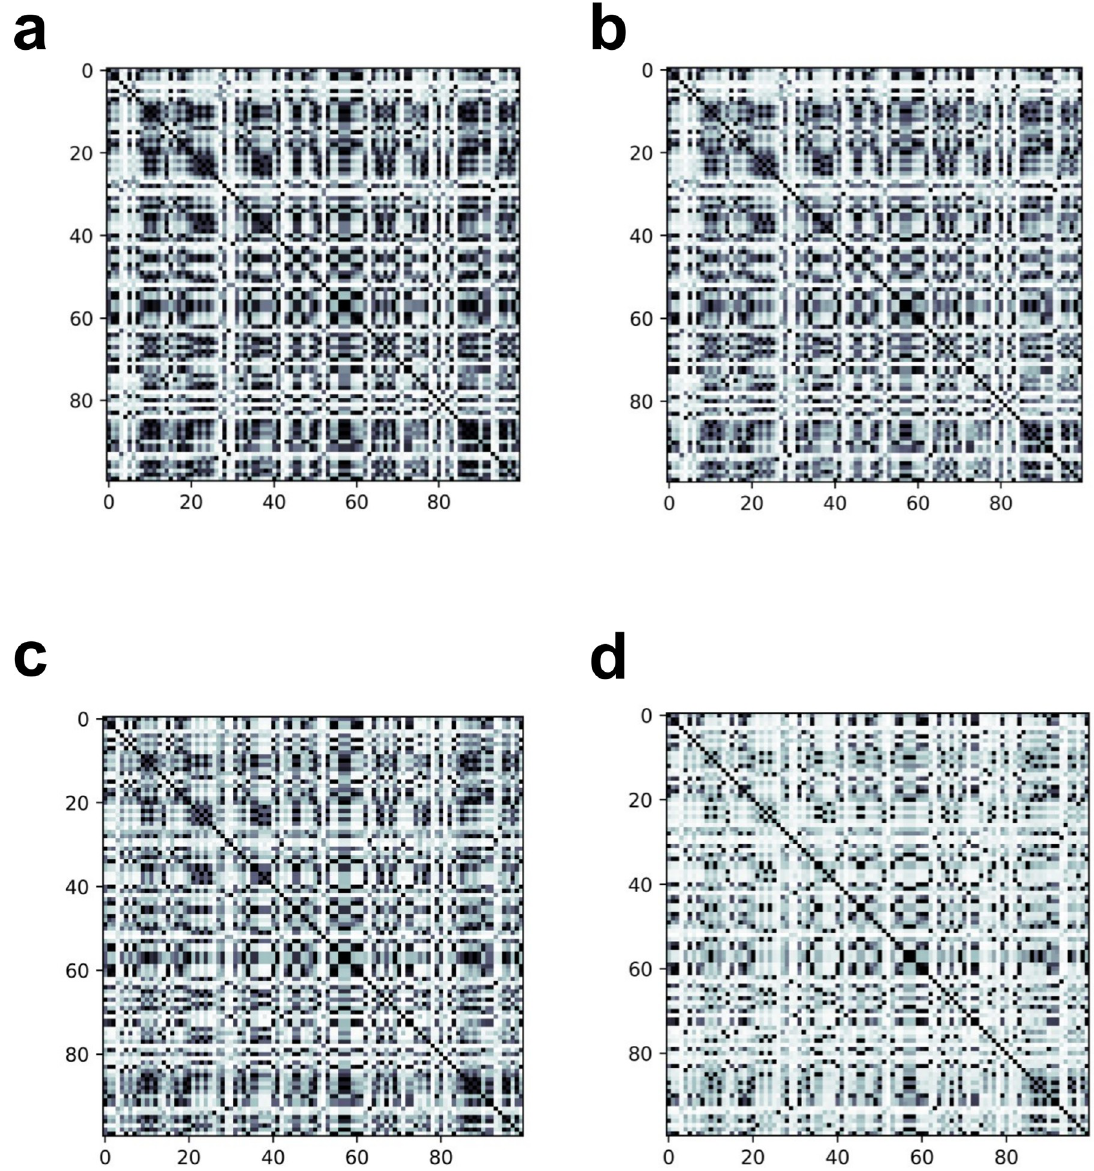
Fig 7. Gram matrices for 100 cases in the Pima Indians diabetes database using the variable ‘age’. Each element of the Gram matrix is normalized from 0 to 1. The stronger the black color, the closer it is to 1. (a) The Gram matrix of the quantum kernel with the number of qubits of 4 and the number of depths of 1. (b) The Gram matrix of the quantum kernel created using ibm_kawasaki with the number of qubits of 4 and the number of depths of 1. (c) The Gram matrix of the quantum kernel with the number of qubits of 5 and the number of depths of 2. (d) The Gram matrix of the quantum kernel created using ibm_kawasaki with the number of qubits of 5 and the number of depths of 2.